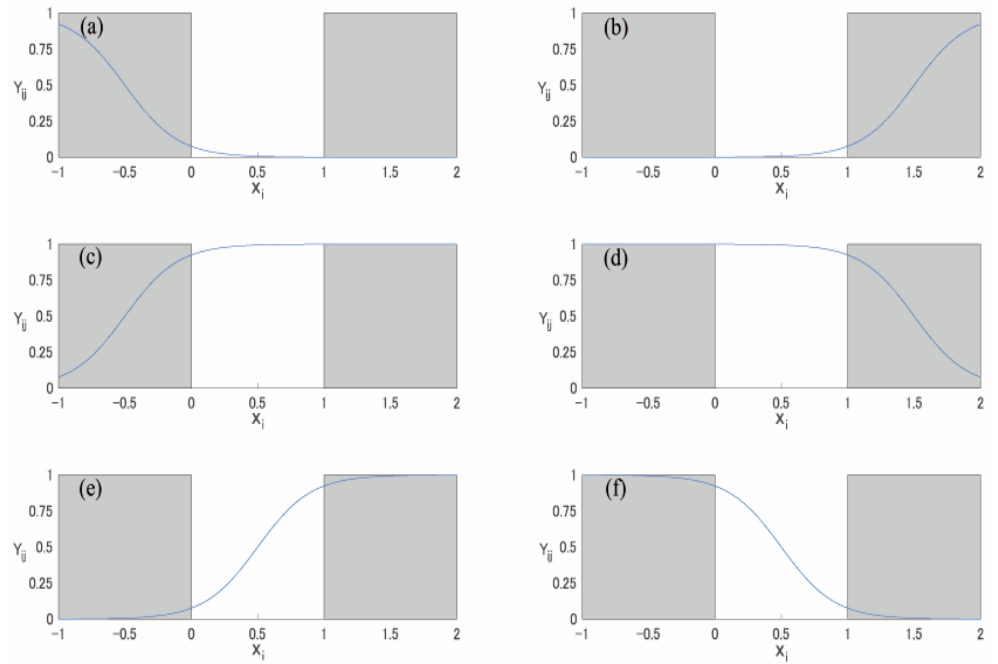
Figure 2. Four types of connection instance in the synaptic layer: ( a ) Constant 0 connection, ( b ) Constant 0 connection, ( c ) Constant 1 connection, ( d ) Constant 1 connection, ( e ) Excitatory connection, and ( f ) Inhibitory connection.